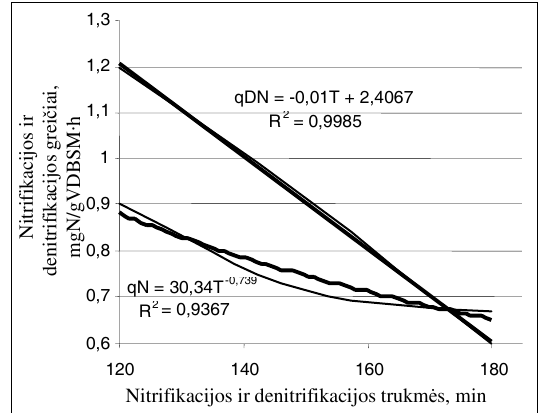
Fig 15. Dependency of nitrification and denitrification rate on aeration regime